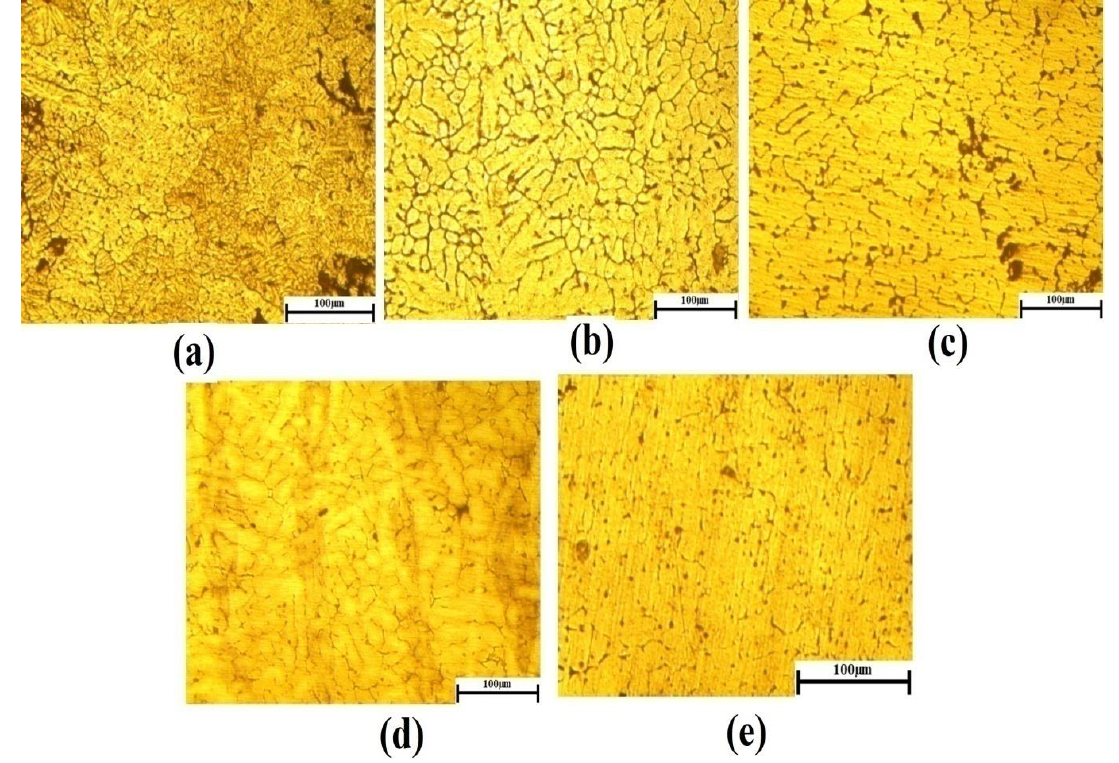
Figure 8. Microstructure of ( a ) non aged and aged at ( b ) 150 °C, ( c ) 250 °C, ( d ) 350 °C and ( e ) 450 °C specimen.